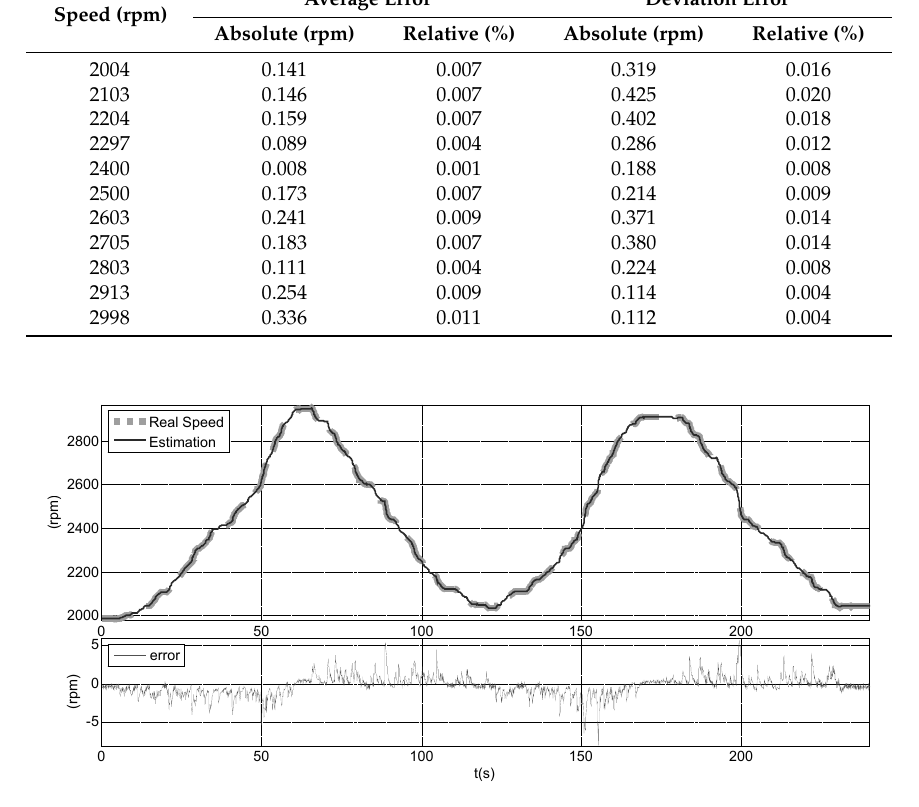
Figure 9. Actual and estimated speed for slow changes in speed.